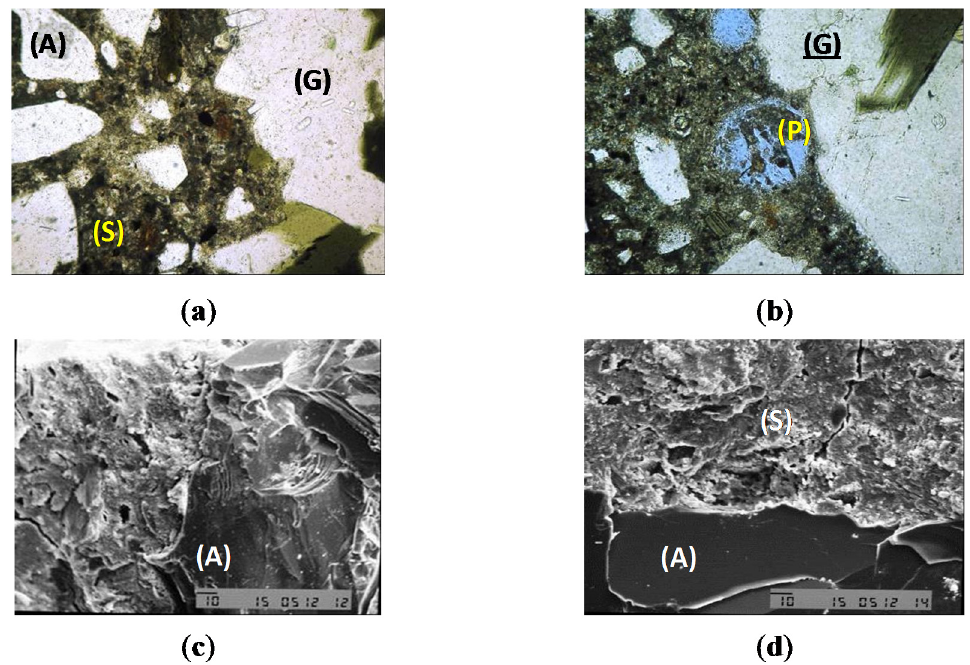
Figure 12. ( a ) SCC_Lab optical microscope image; ( b ) CC_Lab optical microscope image; ( c ) SCC_Lab SEM image; ( d ) CC_Lab SEM image.